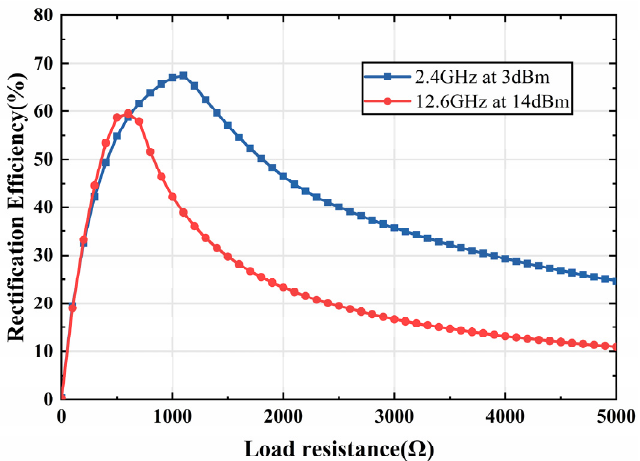
Figure 9. Simulated rectification efficiency of rectifiers versus input power at various loads. ( a ) 2.4 GHz. ( b ) 12.6 GHz.